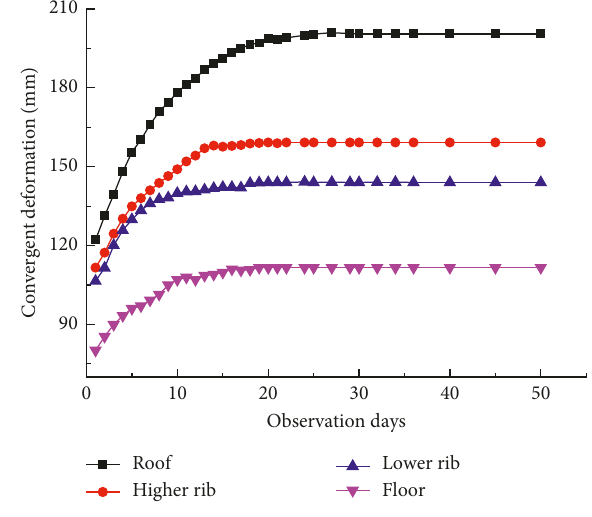
Figure 12: Strata behavior